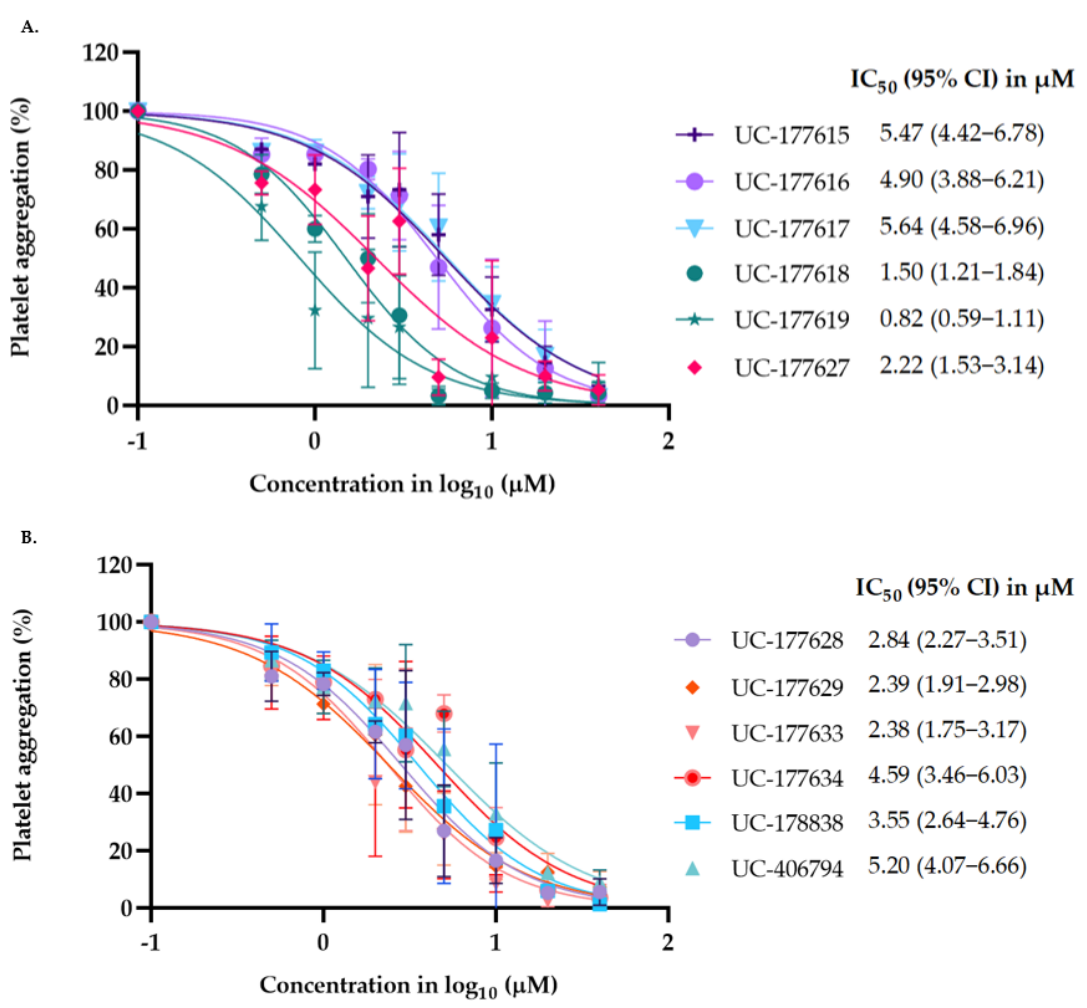
Figure 1. Half-maximal inhibitory concentrations (IC 50 ) of Rhosin-related compounds. ( A , B ) The IC 50 and 95% CI values of active Rhosin-related compounds were calculated using the dose–response curves for washed human platelets using collagen (1 µ g/mL) as an inducer of platelet aggregation. Data are representative of three independent experiments.